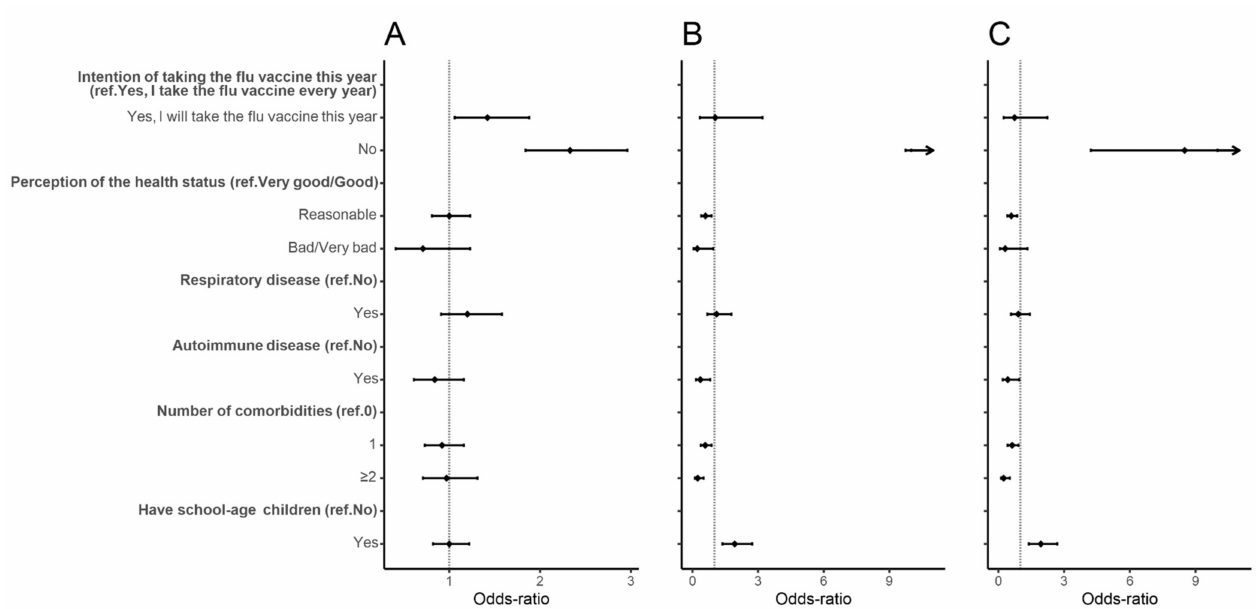
Figure 2. Forest plot of vaccine hesitancy for individual and group influences. Adjusted odds-ratio (adjusted for gender, age, education, and period of questionnaire) and the respective 95% confidence intervals are denoted by black dots and black lines, respectively. Forest plot confidence intervals and estimates were cut off at 10. ( A ) Individuals who would wait to take the vaccine compared to individuals who would take the vaccine; ( B ) individuals who would not take the vaccine compared to individuals who would take the vaccine; ( C ) individuals who would not take the vaccine compared to individuals who would wait to take the